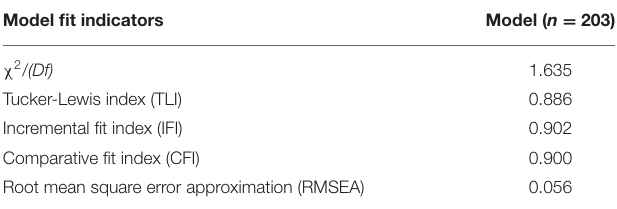
TABLE 4 | Measures of the model fit of the structural equation modelling (SEM) for the cognitive and functional as well as the social/personal categories (nascent